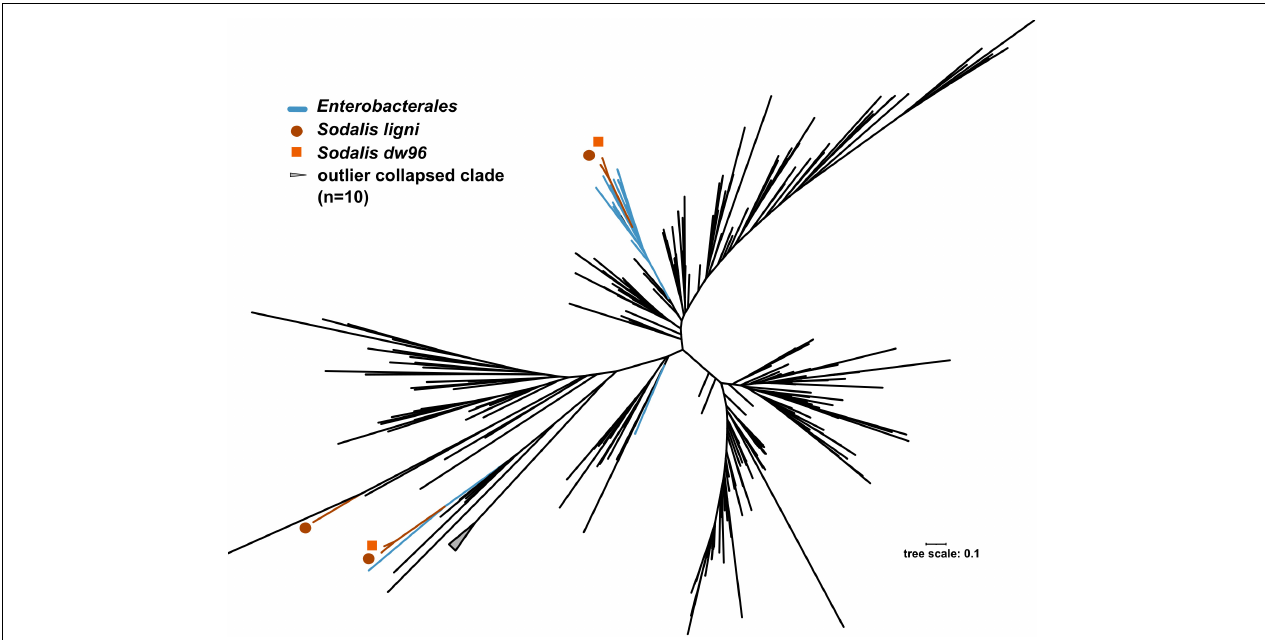
FIGURE 5 | Phylogenetic tree based on nifH genes described from members of the phylum Proteobacteria . Blue branches denote Enterobacterales . Positions of the three nifH sequences from Sodalis ligni are labeled with dark brown circles, two of which are placed together with other enterobacteria. Two nifH sequences from Sodalis dw96 are labeled with bright brown squares, and both are placed together with other nifH from